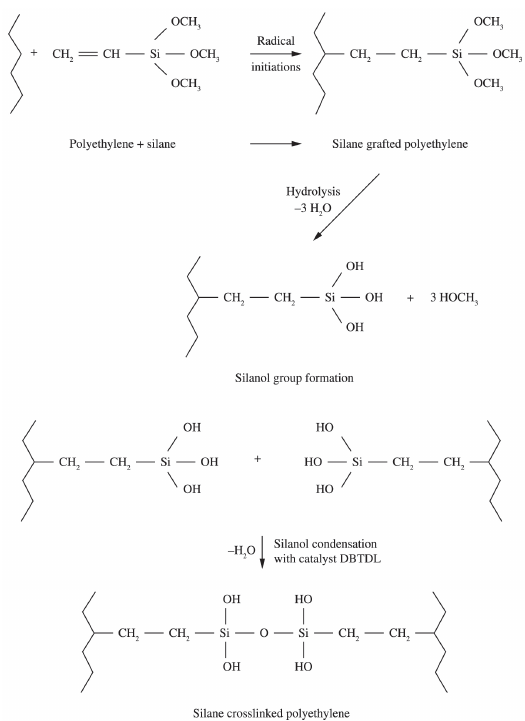
Figure 2. Scheme of the mechanism of silane polyethylene crosslinking 16 . (DBTDL) was donated by Miracema-Nuodex Company, Brazil. All of these reagents were used as